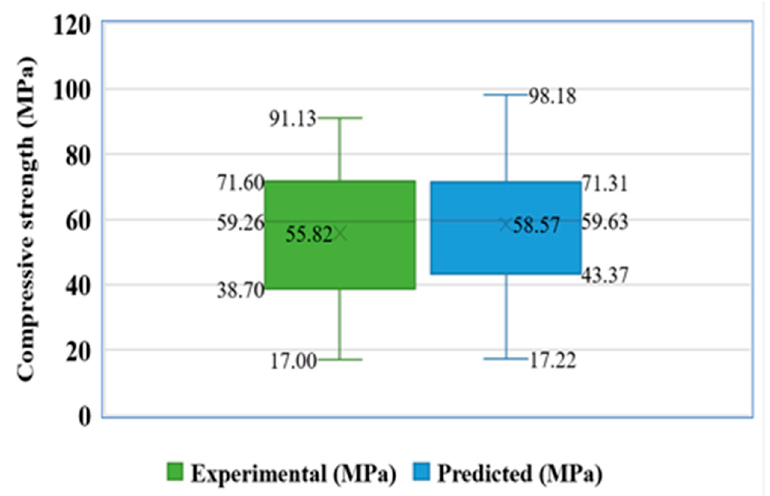
Figure 12. Box plot for predicted and experimental outcomes from SVM model.